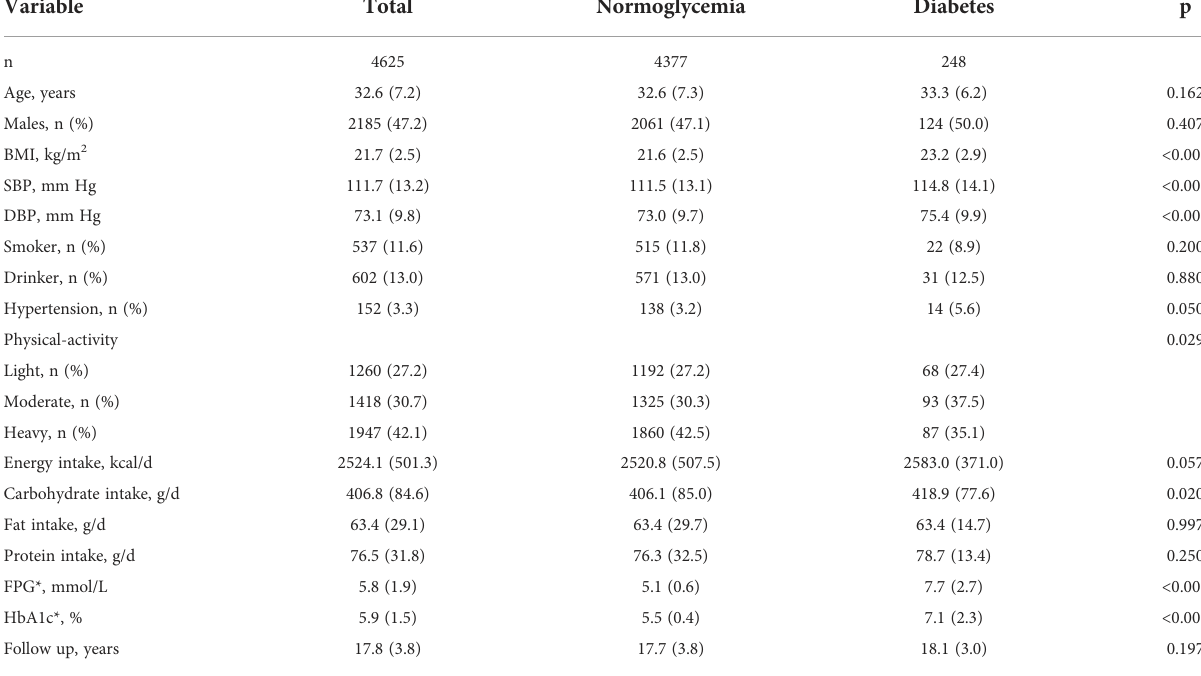
TABLE 1 Baseline characteristics by incident diabetes at